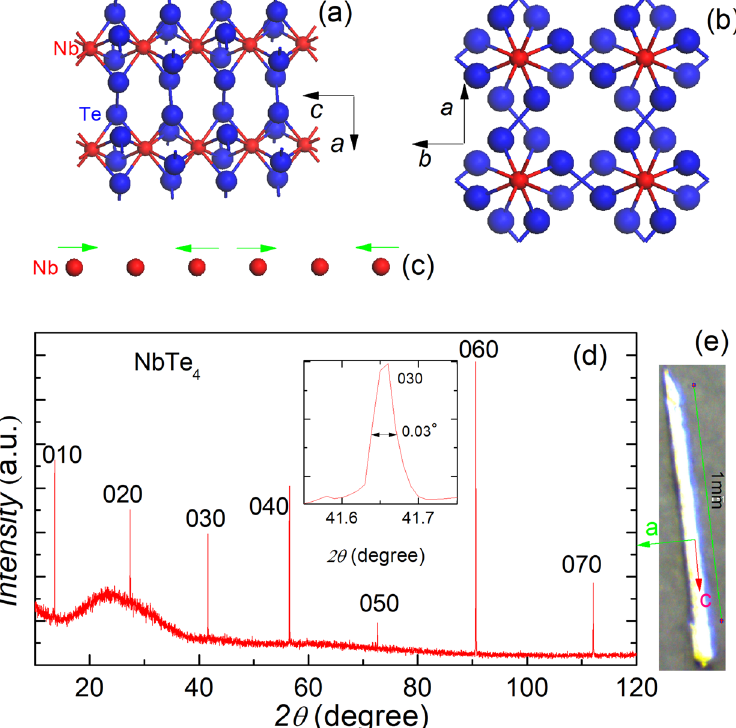
Figure 1. Structural characterization by x-ray diffractions for NbTe 4 . ( a , b ) The basic crystal structure of NbTe 4 projected along the [010] (a) and [001] (b) directions. (c) The red solid circles represent equidistant Nb ions on the axis of a single column of the basic structure; the arrows show the displacements and resultant trimerizations of the Nb ions in the commensurate phase. (d) XRD structure characterization of a NbTe 4 single crystal. Only (0 l 0) peaks can be observed. The inset: The enlarged XRD curve of (030) peak. (e) A typical crystal of NbTe 4 , with crystallographic directions